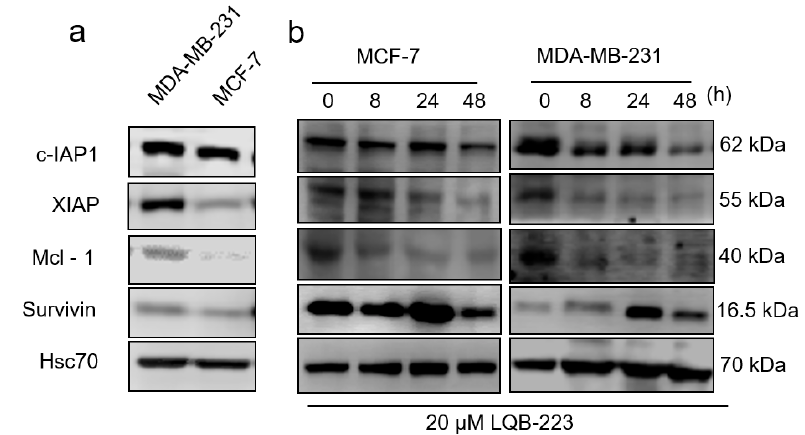
Figure 6. Modulation of chemoresistance-related proteins by the compound LQB-223. Protein levels were assessed by Western blotting assay of whole-cell lysates in MCF-7 and MDA-MB-231 cells. ( a ) Basal levels of apoptosis-associated proteins survivin, XIAP, cIAP-1, and Mcl-1 were compared between the MCF-7 and MDA-MB-231 cells. ( b ) MCF-7 or MDA-MB231 cells were treated with the LQB-223 compound for 8, 24, and 48 h and expression of c-IAP1, XIAP, Mcl-1, and survivin proteins was analyzed by Western blotting. Hsc70 was used as an internal control. Blots are representative of three independent experiments.